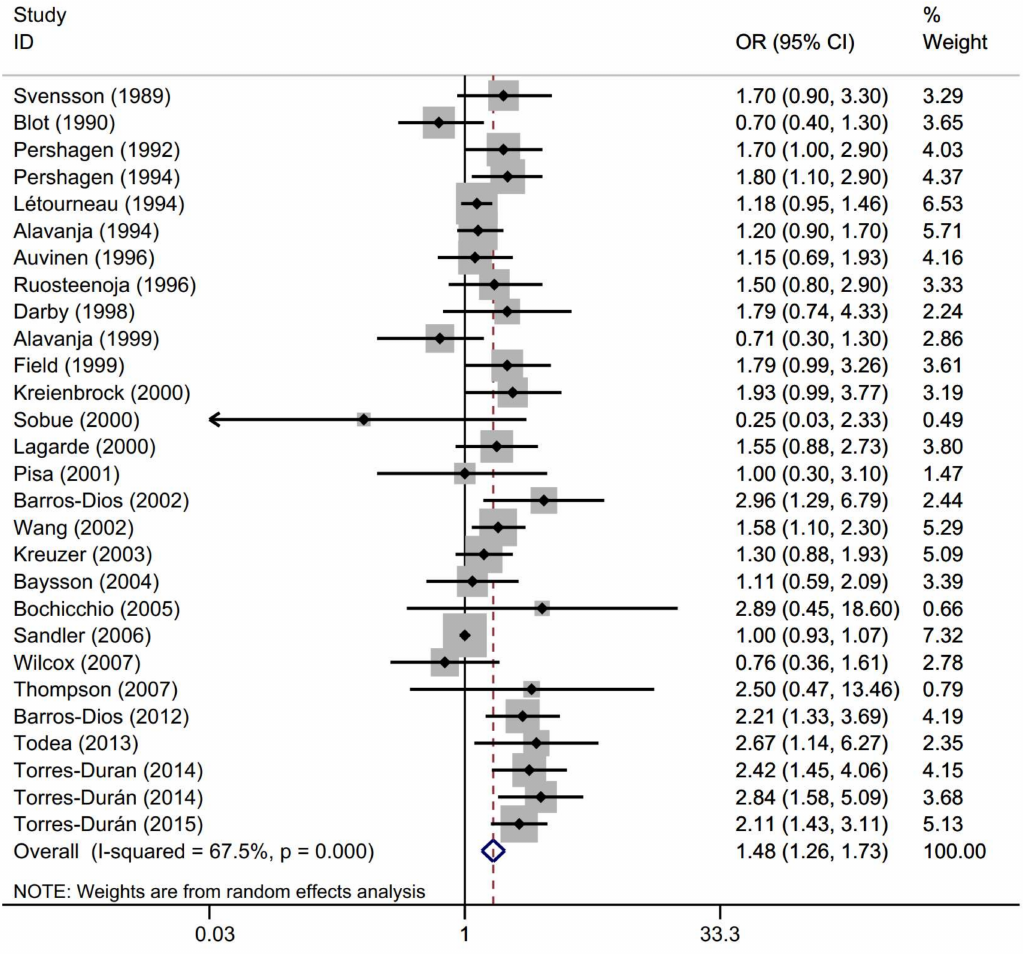
Figure 2. Forest plot for the pooled estimates of the risk of lung cancer with residential radon exposure (highest versus non /